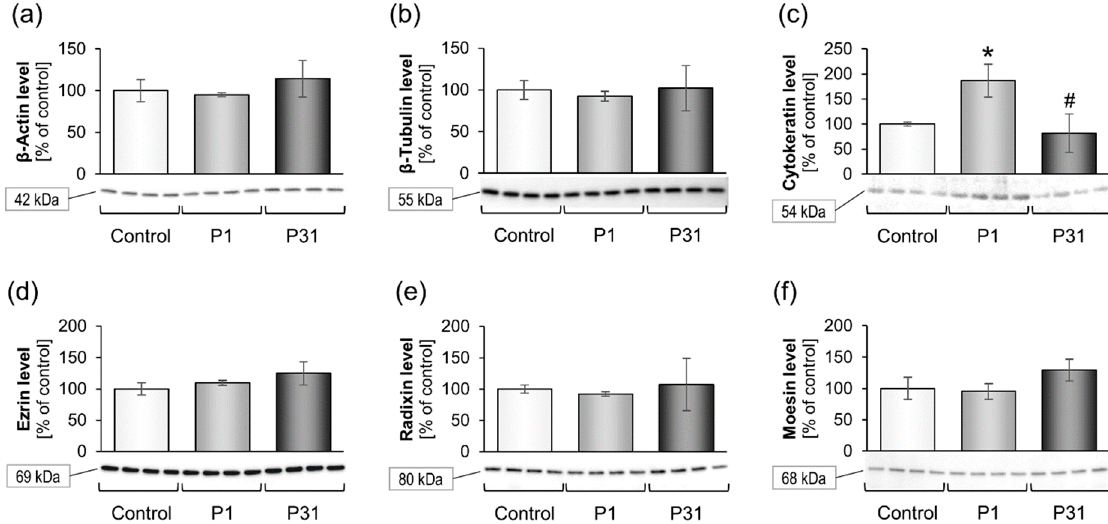
Figure 4. Influence of short-term microgravity on the protein accumulation of cytoskeletal factors. The data are given as mean ± standard deviation. * p < 0.05 vs. Control; # p < 0.05 vs. P1.